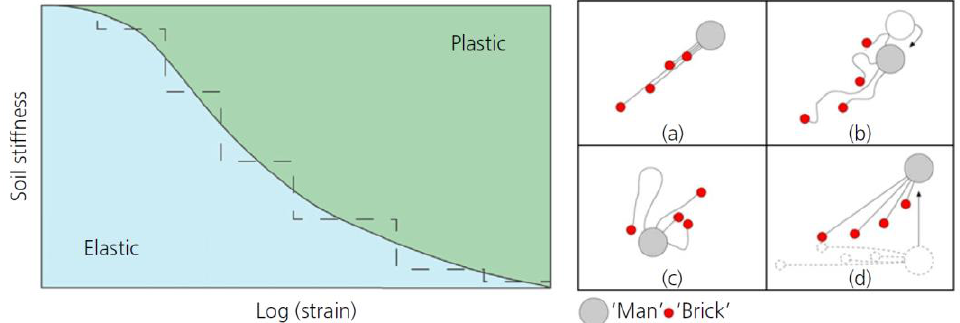
Figure 2. Analogy of the BRICK model: ( a ) bricks in line behind the man when he continues in the same direction—fully plastic behaviour; ( b ) bricks initially do not move when the man turns back—fully elastic behaviour; ( c ) bricks with shorter strings start to move, followed by those with longer strings; ( d ) bricks initially move in the same direction when the man turns 90 ◦ (adapted from Simpson [8] by [32]).